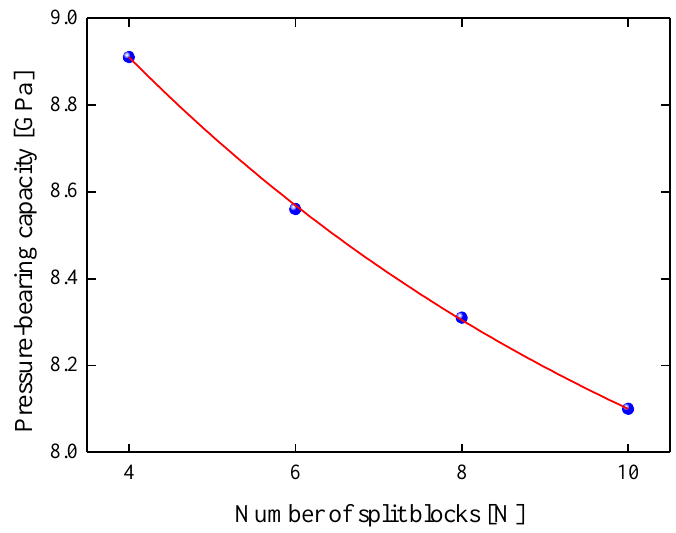
Figure 11. Relationships of pressure-bearing capacity with the number of split blocks.